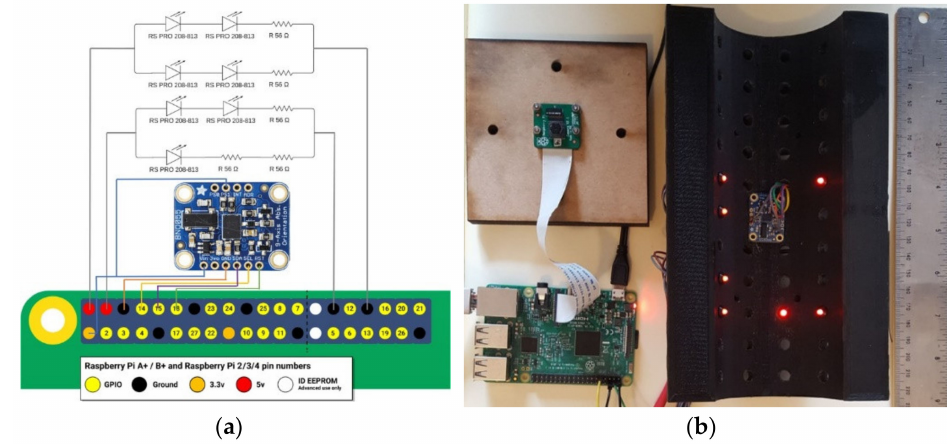
Figure 2. System configuration: ( a ) Wiring; ( b ) Full